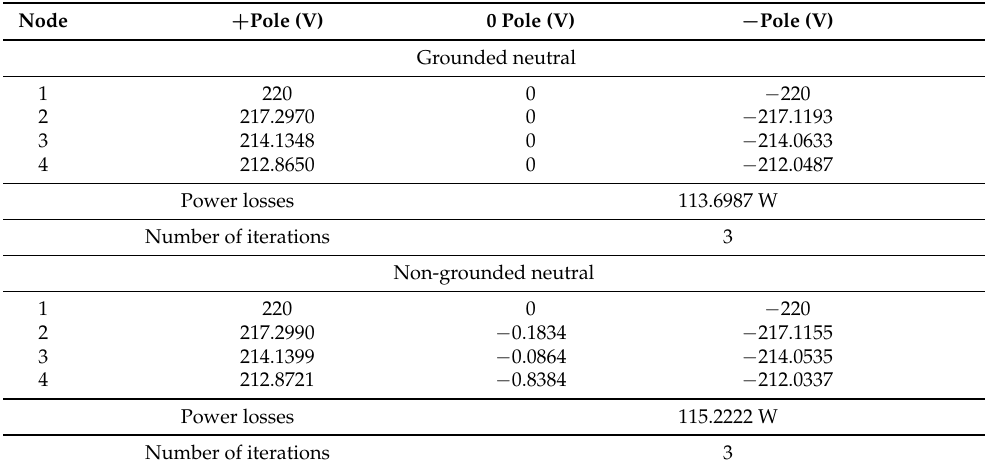
Table 4. Voltage profiles for both simulation cases with the proposed hyperbolic power flow approximation.